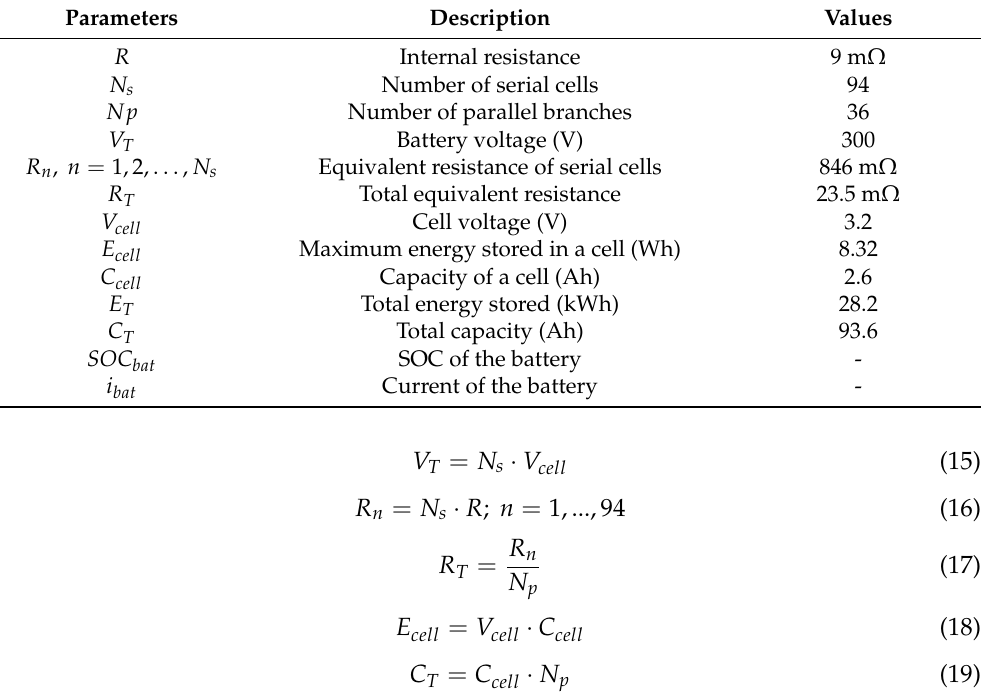
Figure 7. Basic model of the ultracapacitor. Table 3. Battery